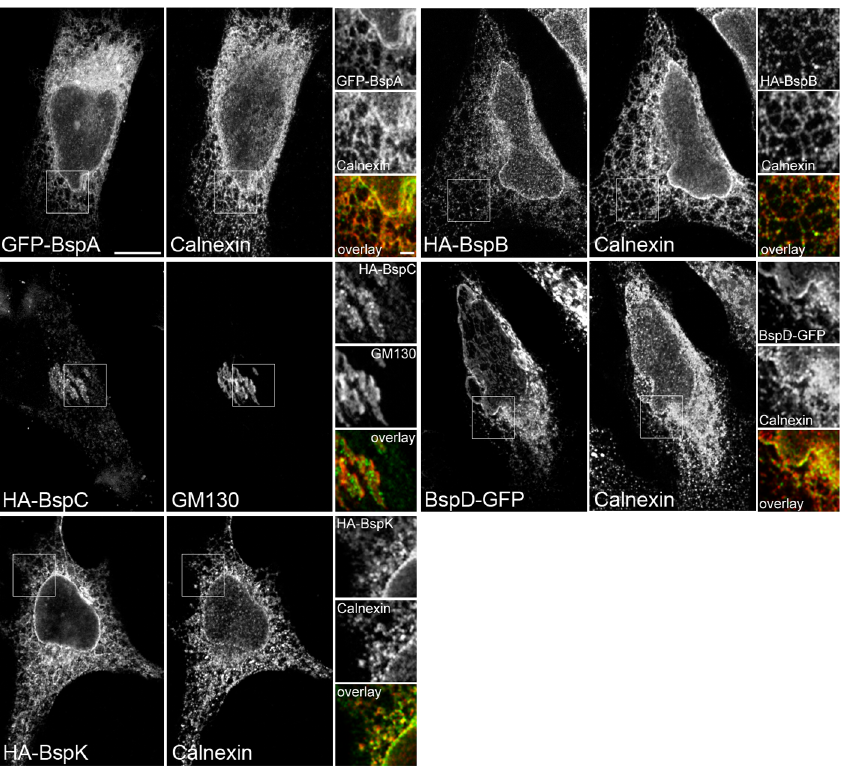
Figure 4. A subset of Bsp effectors target the host secretory pathway. Representative confocal micrographs of HeLa cells transfected with the indicated HA- or GFP-tagged Bsp protein and immunostained for HA (green) and calnexin or GM130 (red) at 12 h post-transfection. Magnified insets show single channel and overlay color images of the boxed region. Scale bar, 10 and 2 m m.